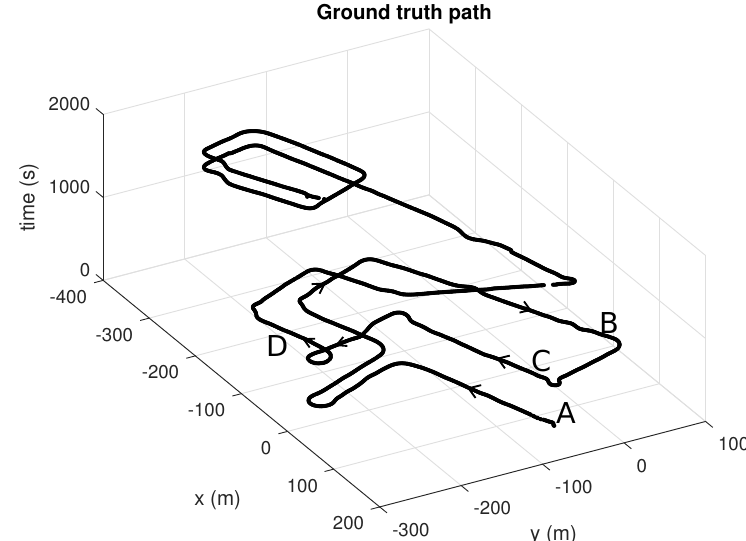
Figure 6. Bird-eye view of ( a ) the ground-truth map used in the benchmark, along with ( b ) a corresponding satellite image of the UAL campus.